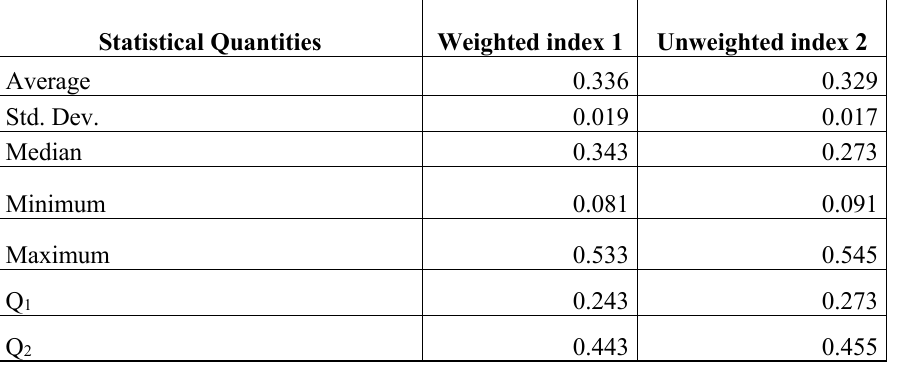
Table 5. Results of financial statement disclosure performance index (ID (1;2): weighted and unweighted index: year 2016